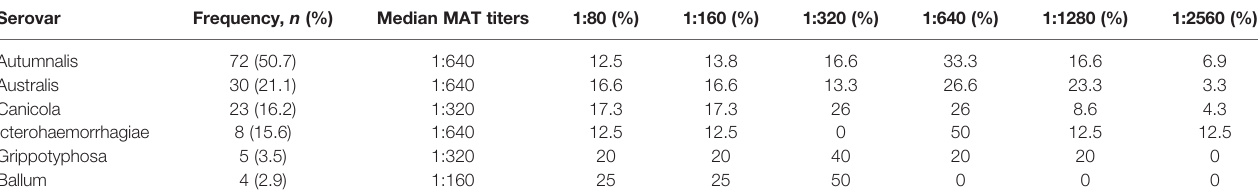
MAT, microscopic agglutination test.